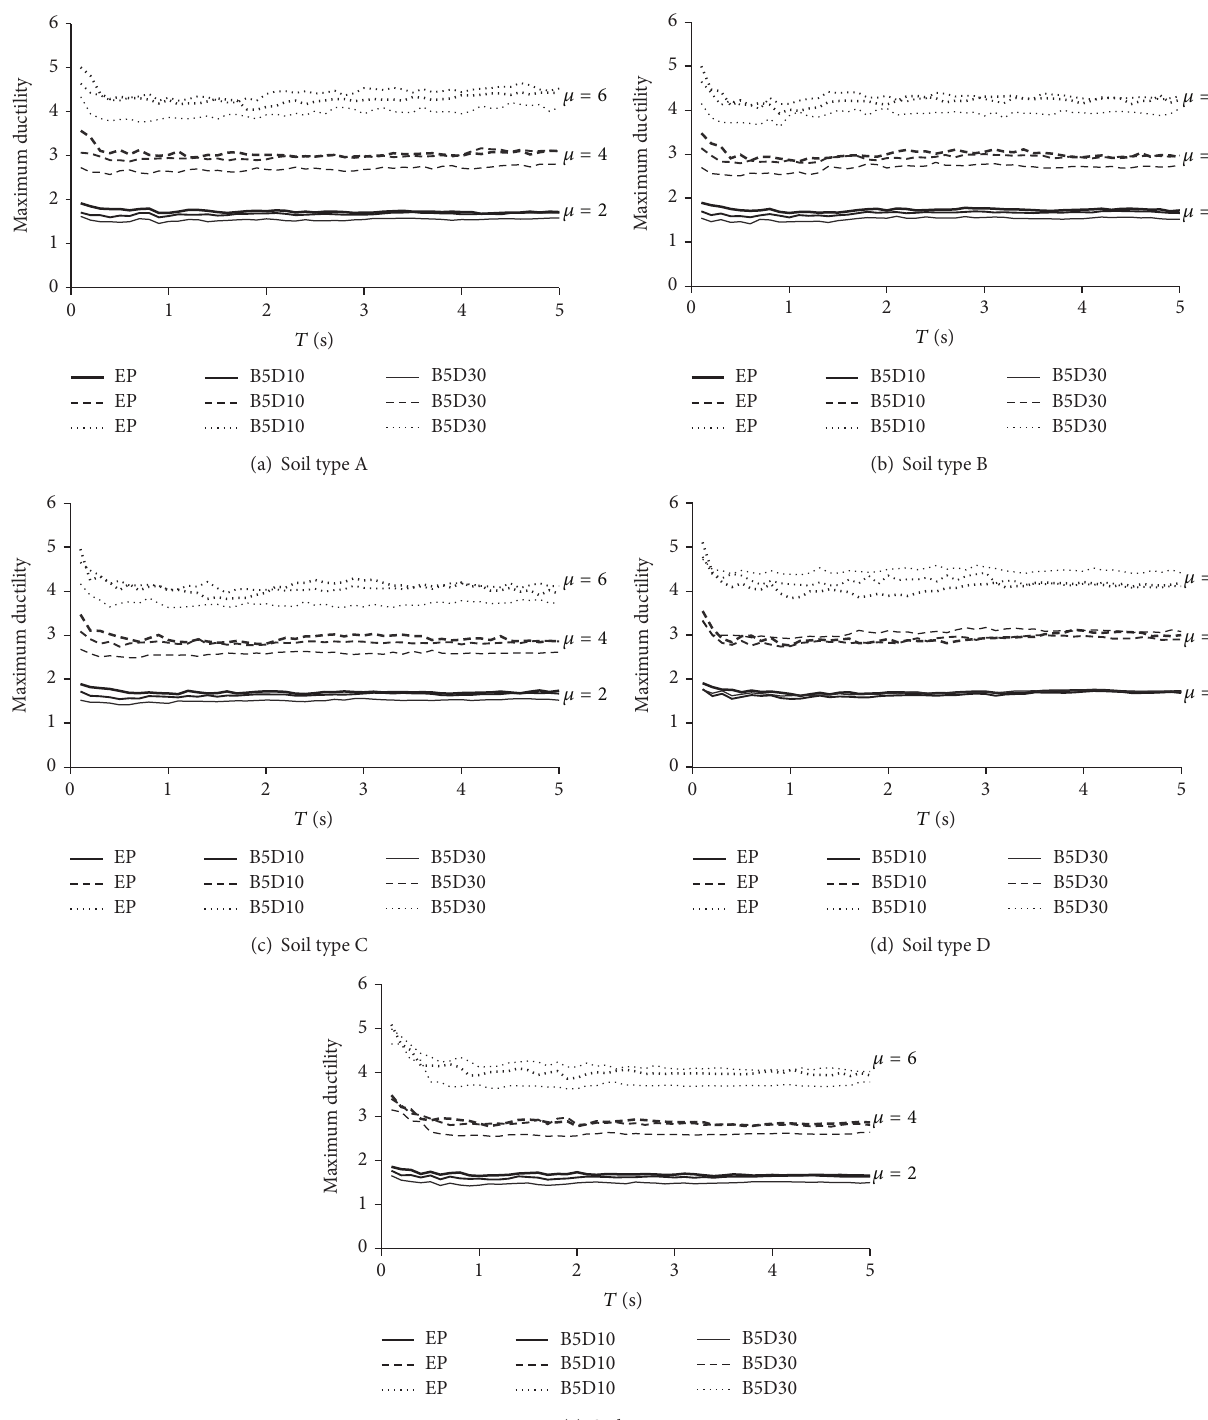
Figure 4: Average target ductility for different hysteretic models and ultimate ductilities.